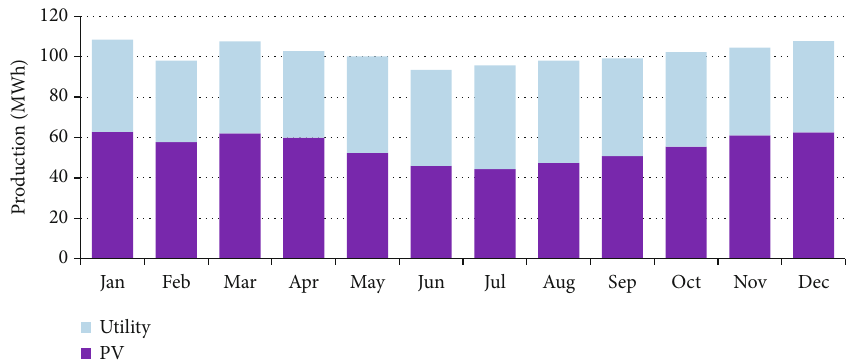
Figure 45: The electrical production for both utility and the solar PV microgrid for the proposed technology in South